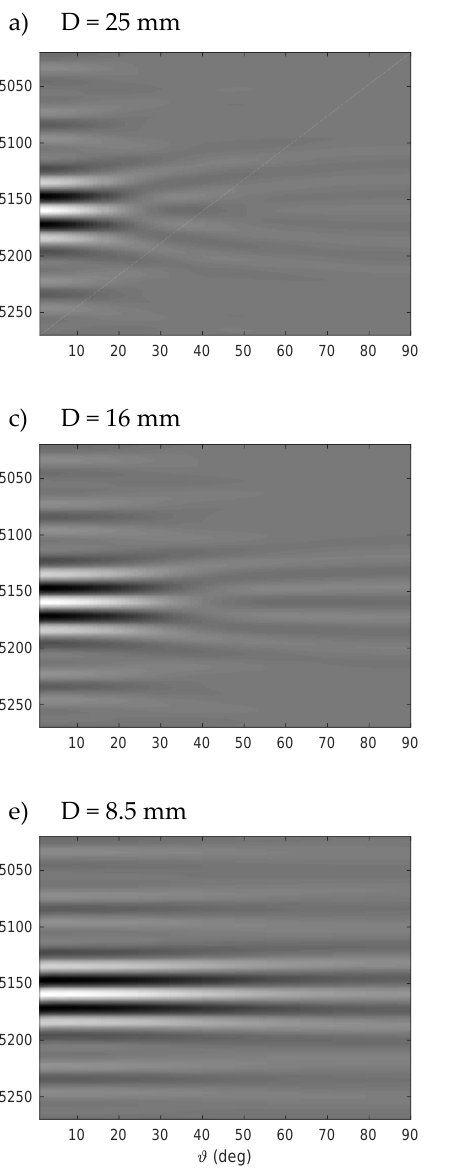
Figure 4. Cross-correlation values along a semicircular path at distance R = 1 m from the emitting transducer at di ff erent transducer apertures D = {25, 20, 16, 13.1, 8.5, 6} mm. From D = 25 mm down to D = 6 mm, it is possible to appreciate the progressive appearance of a single correlation peak, which makes the identification of the TOA univocal.